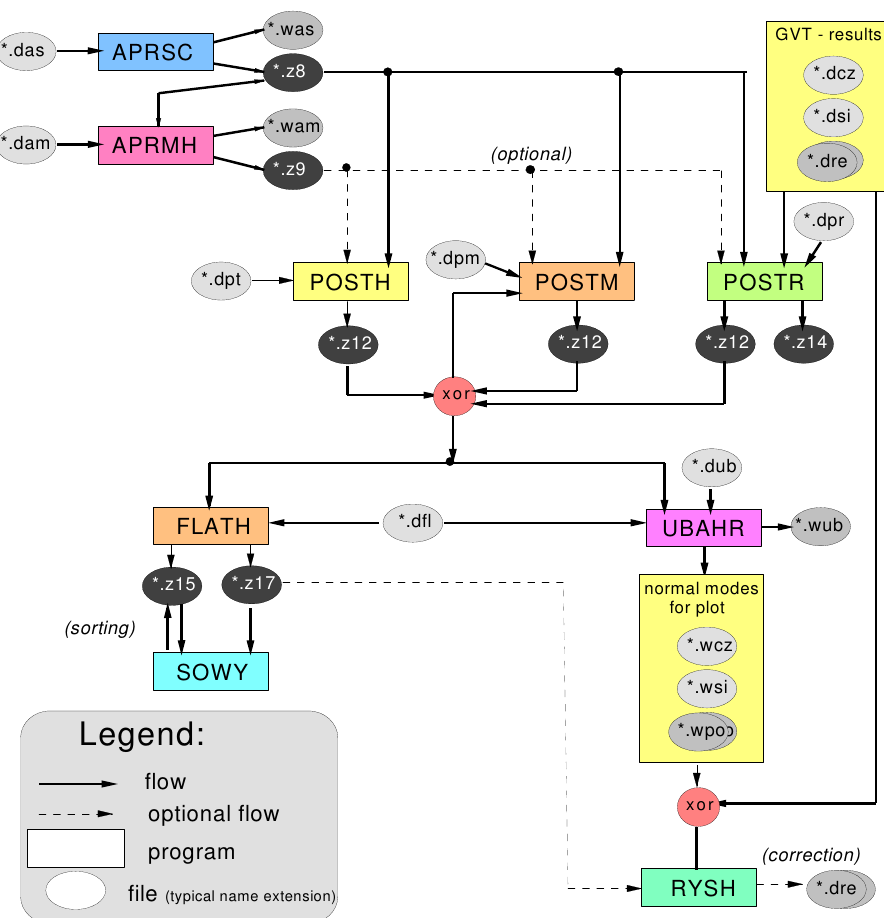
Fig 1. The flutter calculation flow